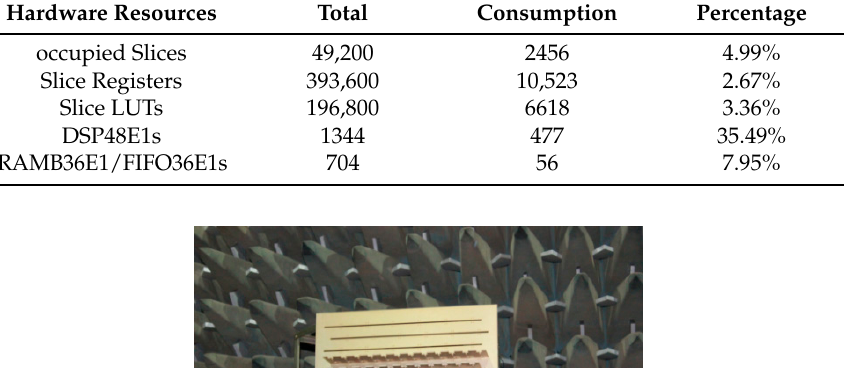
Figure 15. Experiment in a microwave anechoic chamber.